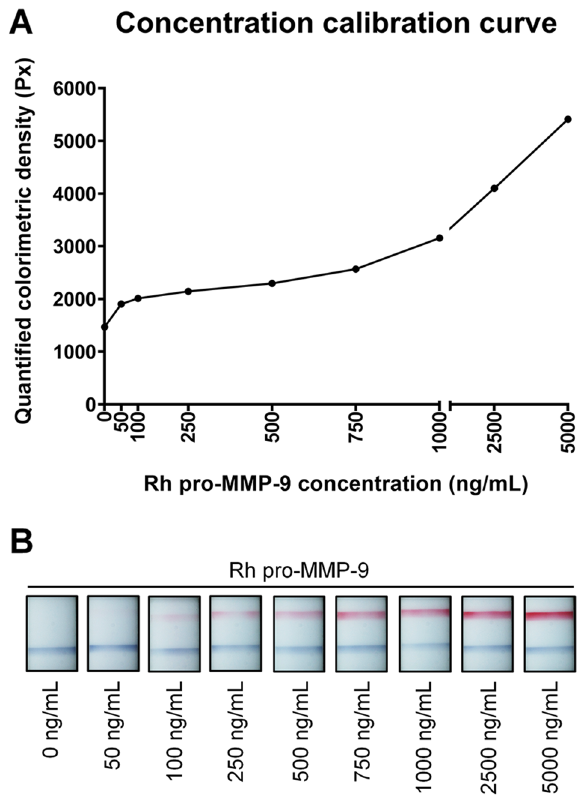
Figure 2. Standard calibration curve showing the concentration-band density relationship using various concentrations of recombinant human (rh) pro-matrix metalloproteinase (MMP)-9 solutions. ( A ) There are slow progression sections below 100 ng/mL and over 750 ng/mL of concentration while there is a slow progression section between concentrations of 100 ng/mL and 750 ng/mL. The values in each concentration is an average value from 3 independent samples of the same concentration. ( B ) Representative photographs of readout windows of the point-of-care matrix metalloproteinase (MMP)-9 immunoassay at the different concentrations of rh MMP-9 from 0 ng/mL to 5000